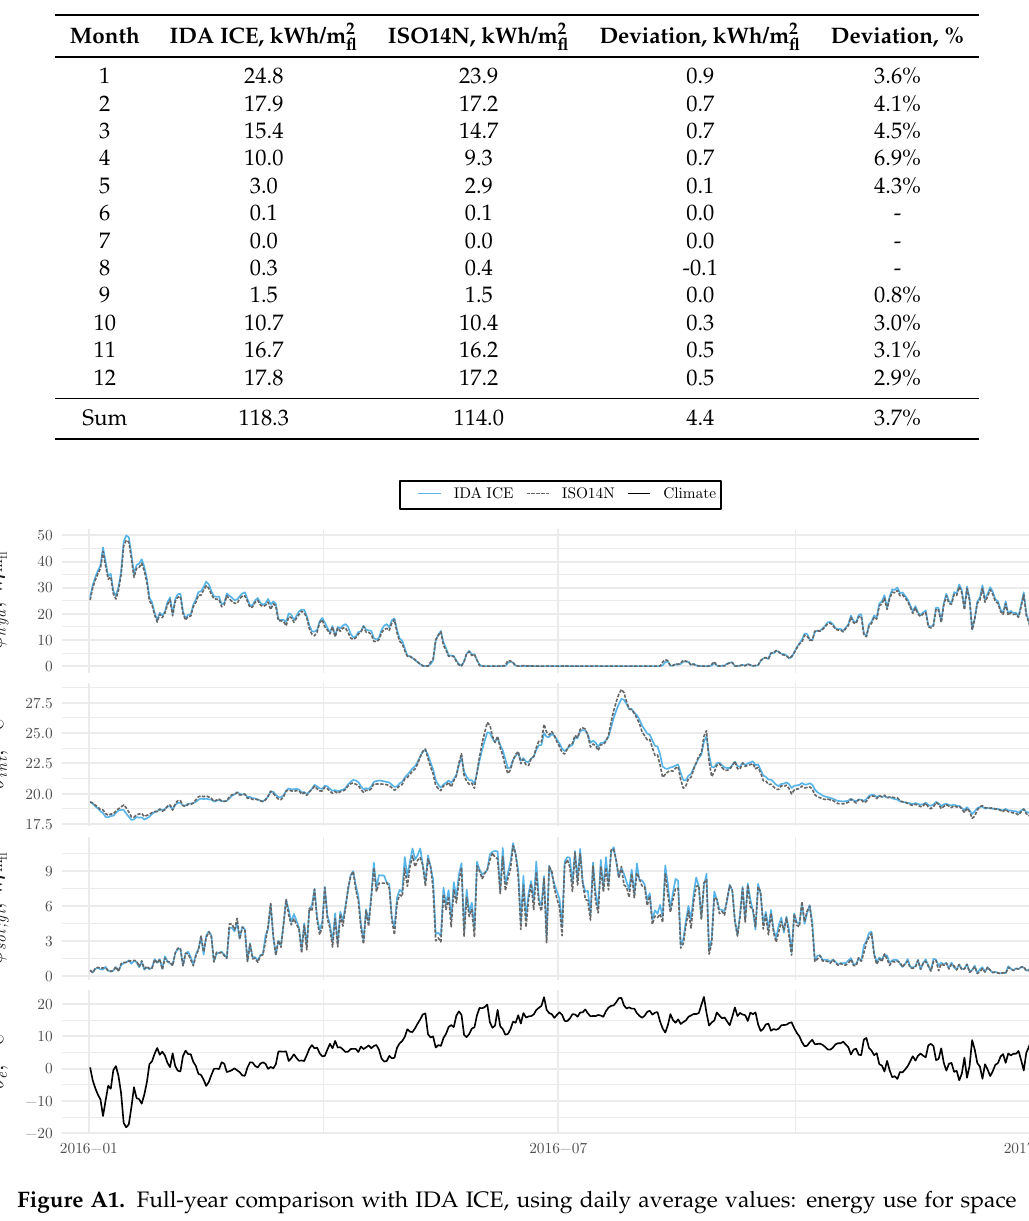
Figure A1. Full-year comparison with IDA ICE, using daily average values: energy use for space heating, ( φ hyd ), internal air temperature ( θ int ), solar heat gains through glazing ( φ sol ; gl ) and external air temperature ( θ e